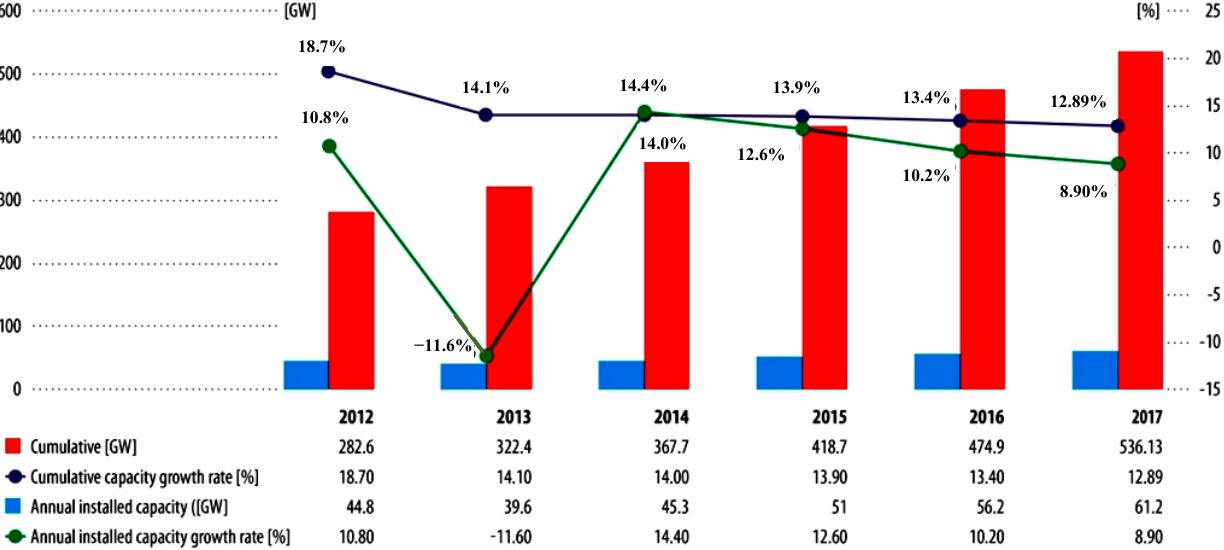
Figure 1. Wind energy world market forecast for 2013–2017 [1]. Reprinted/Reproduced with permission from [1]. Copyright 2013, Global Wind Energy Council